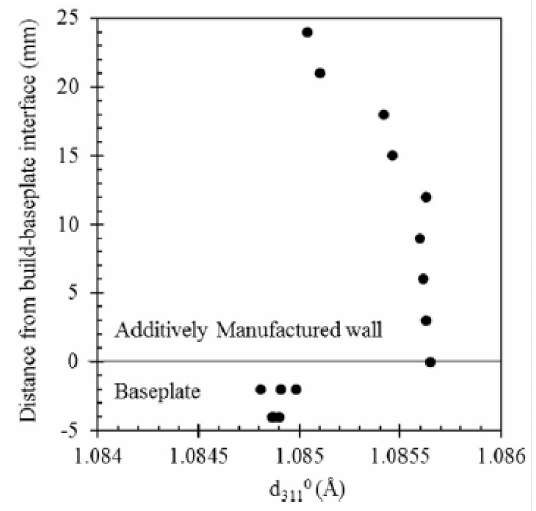
Figure 10. Reference d 0311 as a function of distance from the build-baseplate interface measured by neutron diffraction in the 40 s dwell time stress-free reference samples without heat treatment. Reproduced from [31] with permission from